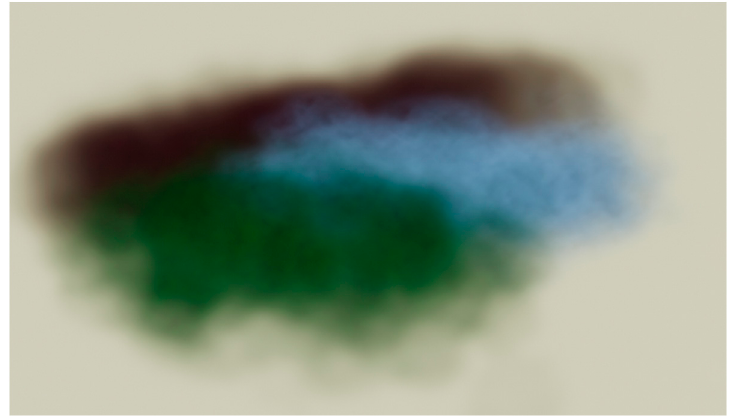
Figure 26. A virtual illustration of the overall sentiment scores generated by participants’ shared content about the selected exhibits at a certain point of time.